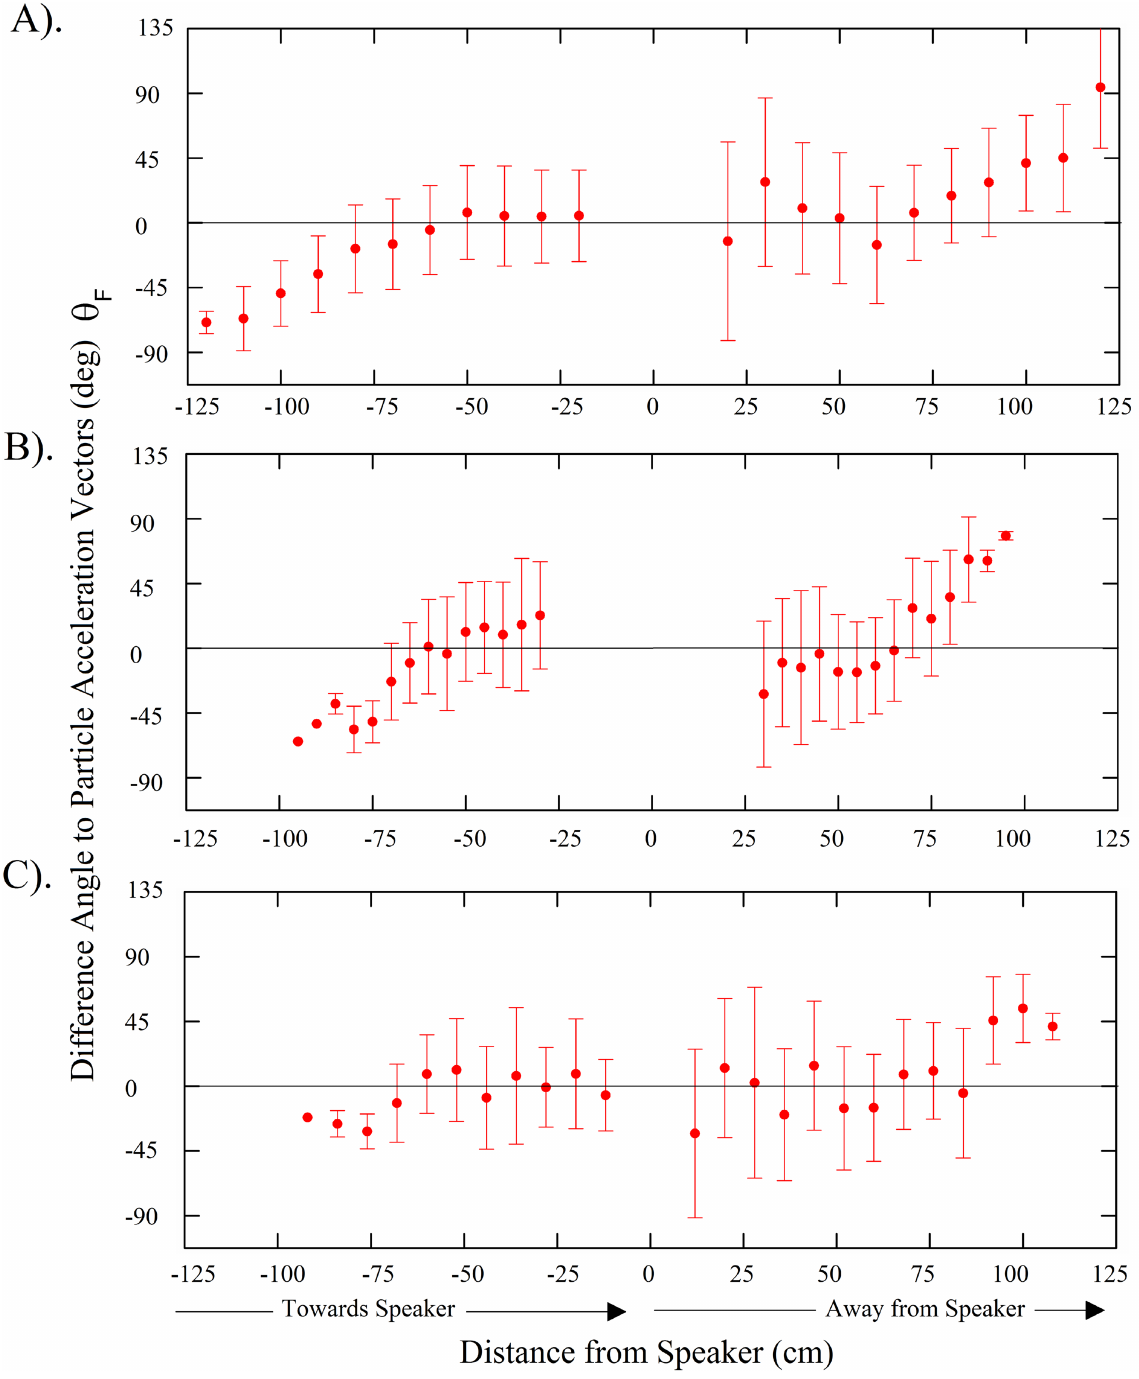
Fig 7. Differenceangles of fish bearing relative to the local particle acceleration vectors for (A) common carp, (B) silver carp, and (C) bighead carp. Differenceangleswere calculatedalong swimmingtrajectoriesof fish that swam within 30-cm of an active speakerduringplayback. Trajectories were analyzedfrom all four trials. Negativedistances indicatemovementtowards the speaker, whilepositive indicate movement away. Bars are the standarddeviation.